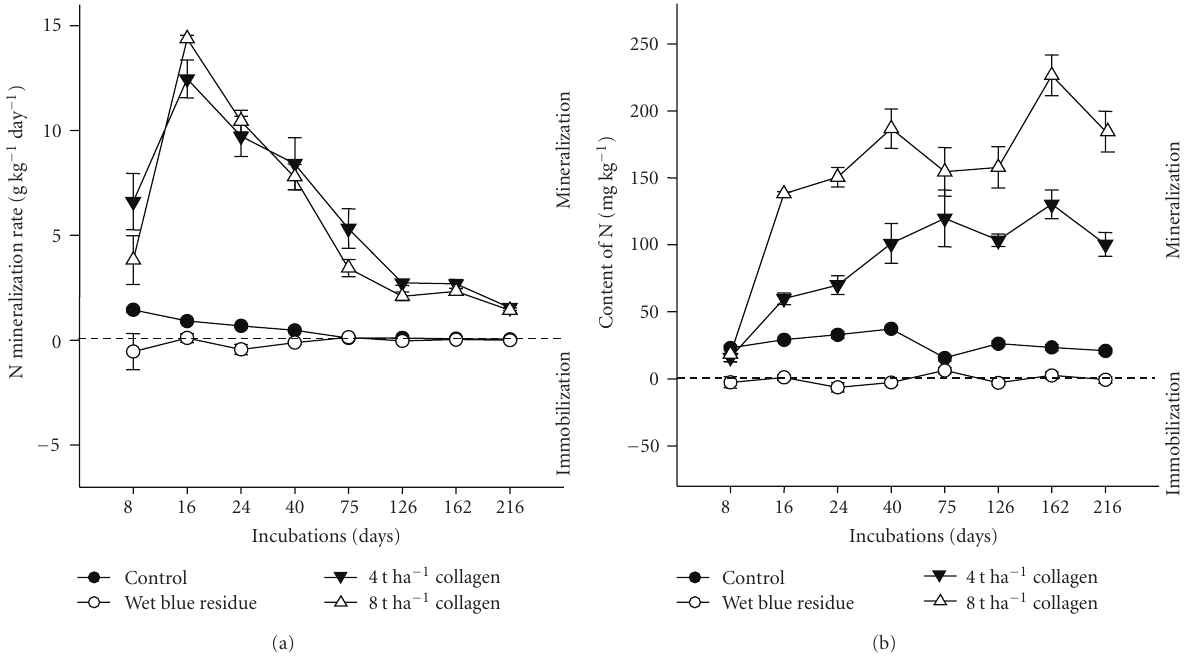
Figure 4: Mineralization rates (a) and the N mineralized (NO 3 − + NH 4+ ) contents (b) in the treatments 4 and 8 tha − 1 of the collagen and in the control and wet blue residue for 216 days incubation. Medium values of the five replicates.